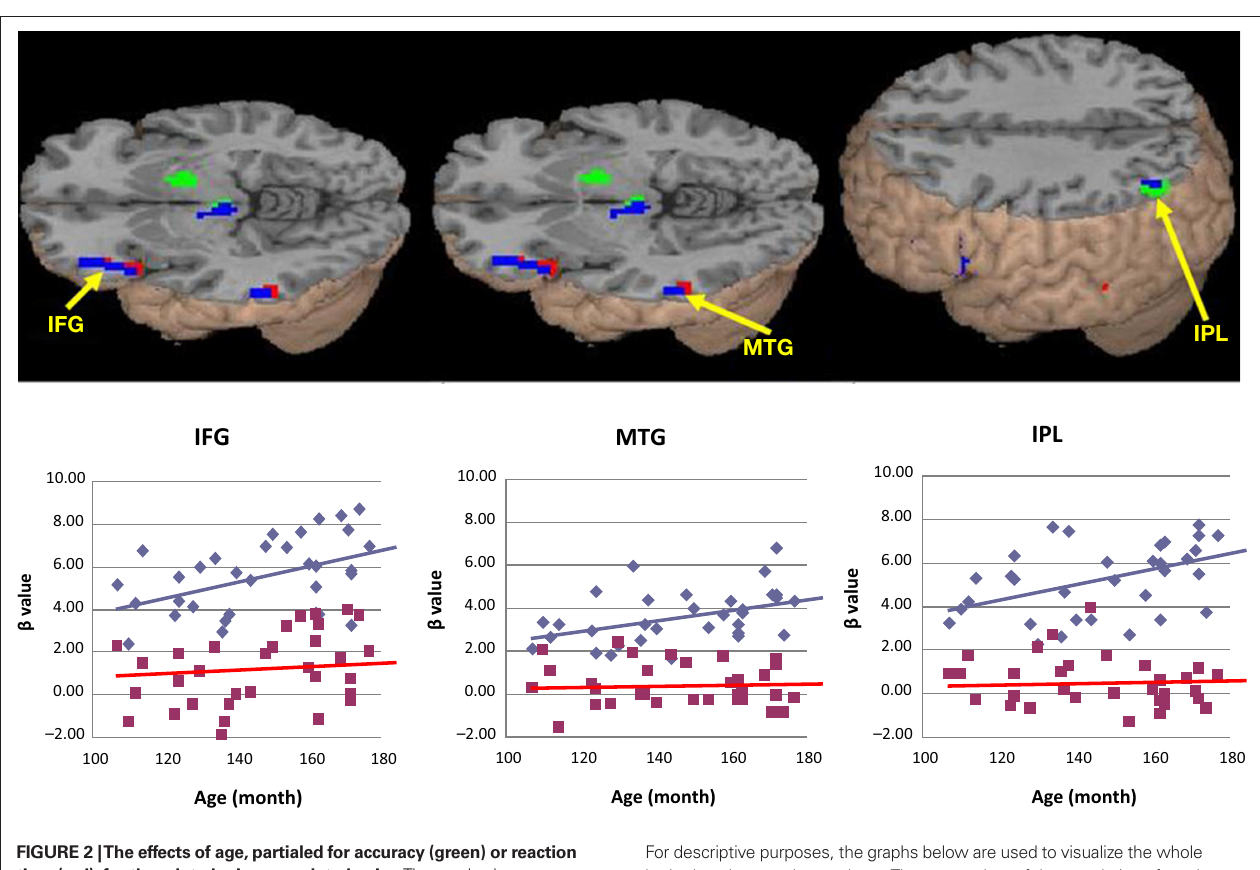
For descriptive purposes, the graphs below are used to visualize the whole brain data that are shown above. The scatterplots of the correlation of age in months with the related (blue) and unrelated (red) conditions in these three regions are presented below the brain images. Beta values were taken from the peak voxel of the related minus unrelated contrast partialed for reaction